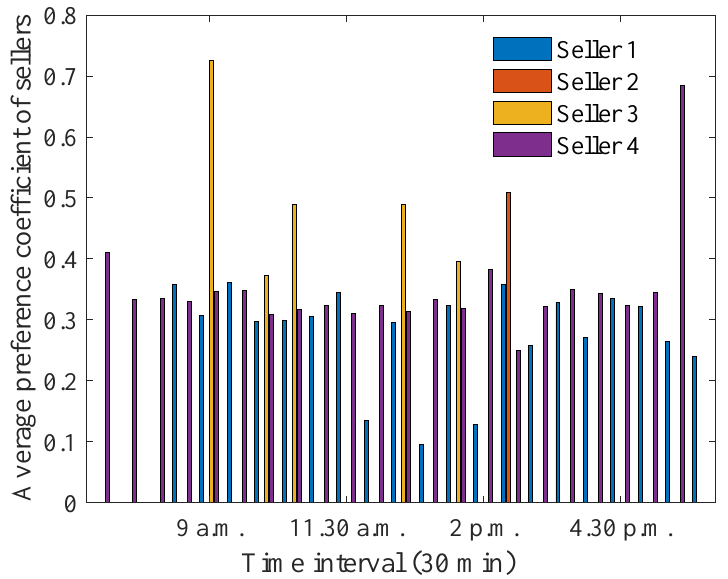
Figure 5. Optimum preference coefficients for sellers during winter months.